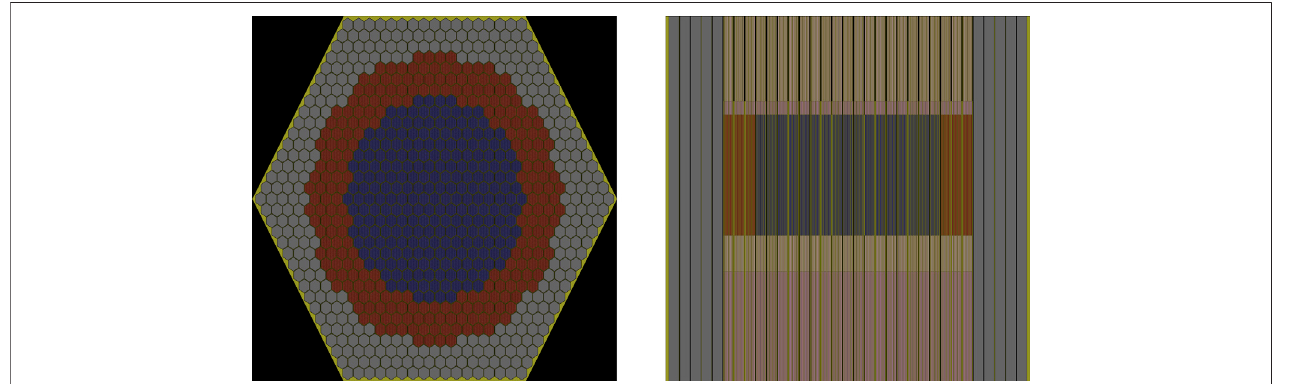
FIGURE 7 | The radial and axial cross sections of the sodium fast reactor benchmark.